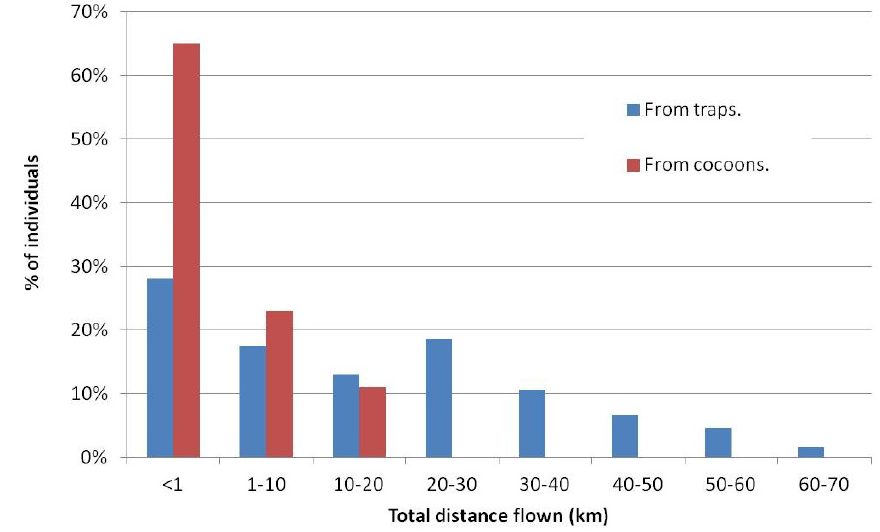
Figure 16. Total distance flown (in km) by individuals coming from traps [15] versus distance flown by individuals coming from cocoons (this